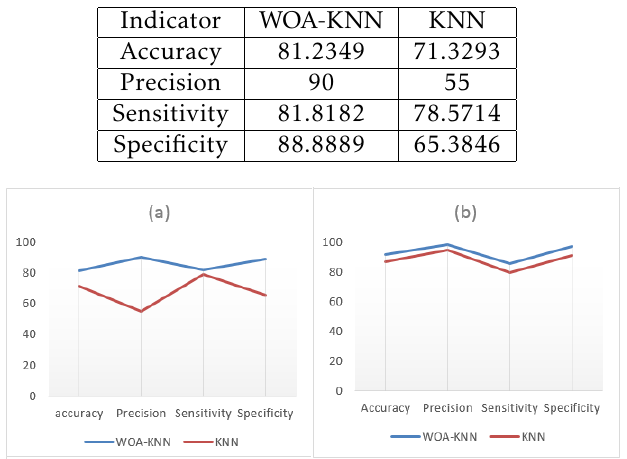
Figure 3. (a) The results obtained by WOA -KNN hybrid algorithm for BUPA Data set (b) the results obtained by WOA -KNN hybrid algorithm for ILPD Data